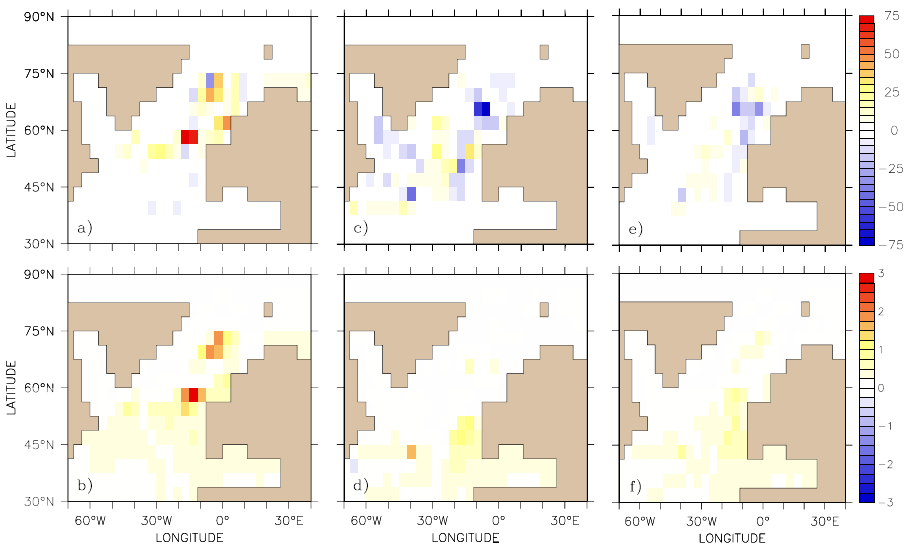
Fig. 7. Anomalies at the transition stage relative to the stadial regime under CO 2 -only forcing conditions of (a) surface heat flux in Wm − 2 (negative values indicate heat loss by the ocean to the atmosphere) and (b) sea surface temperature during summer months (June–August) in K; (c–d) and (e–f) same fields during winter (January–February) and for the annual mean,